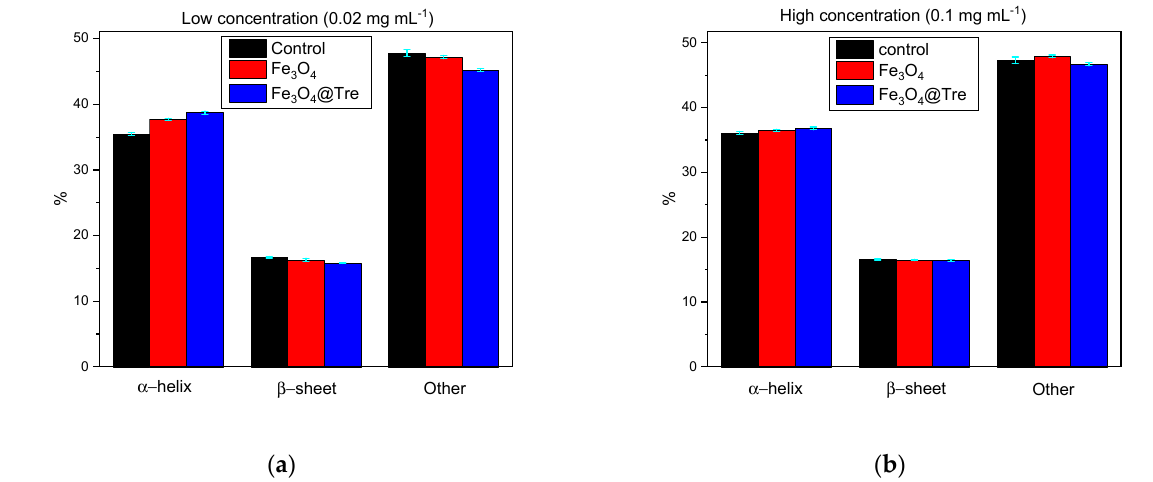
Figure 7. Qualitative diagrams of CD test results in different concentrations of ( a ) 0.02 mg mL − 1 NPs, and ( b ) 0.1 mg mL − 1 NPs.